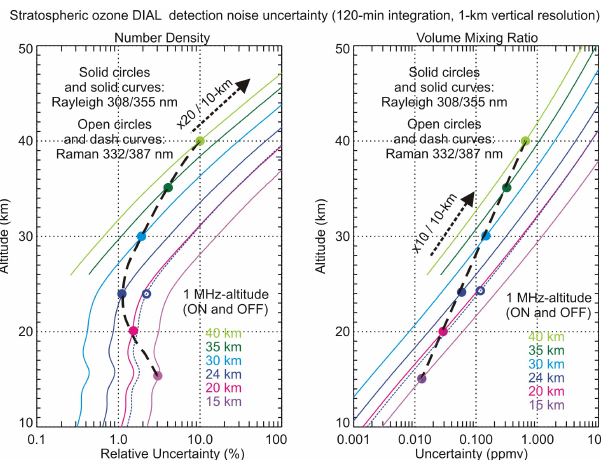
Figure 1. Ozone number density relative uncertainty (left) and ozone mixing ratio uncertainty (right) owing to detection noise for stratospheric ozone DIAL systems of varying performance, and for a 120min integration time and 1km vertical resolution. The sys- tems’ performance is measured as the altitude of 1MHz count rate for both the ON and OFF channels signals. See text for